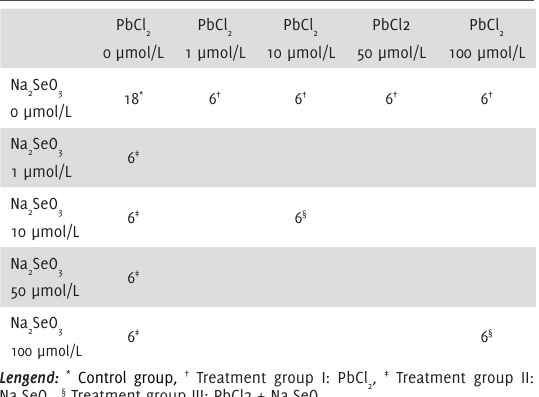
Table 1. Treatment Groups.